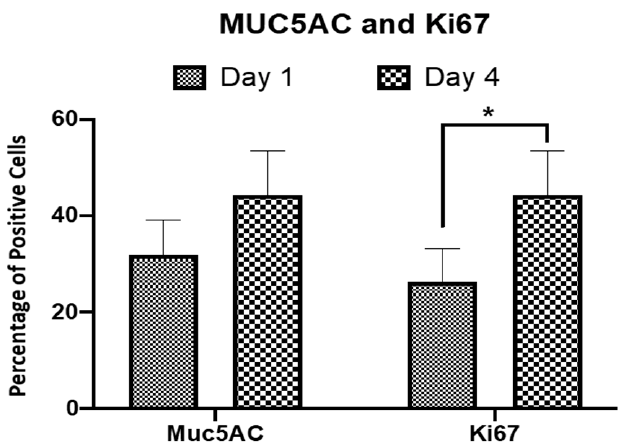
Figure 5. Percentage of mucin secreting and proliferative respiratory epithelial cells residing within the human tissue respiratory epithelial construct. The population of mucin secreting cells increased from day 1 to day 4. Similarly, the percentage of proliferative cells increased from day 1 to 4. Values are presented as mean ± standard error of mean. Two-way ANOVA was used to compare the data between the groups, and * p < 0.05 was considered statistically significant.